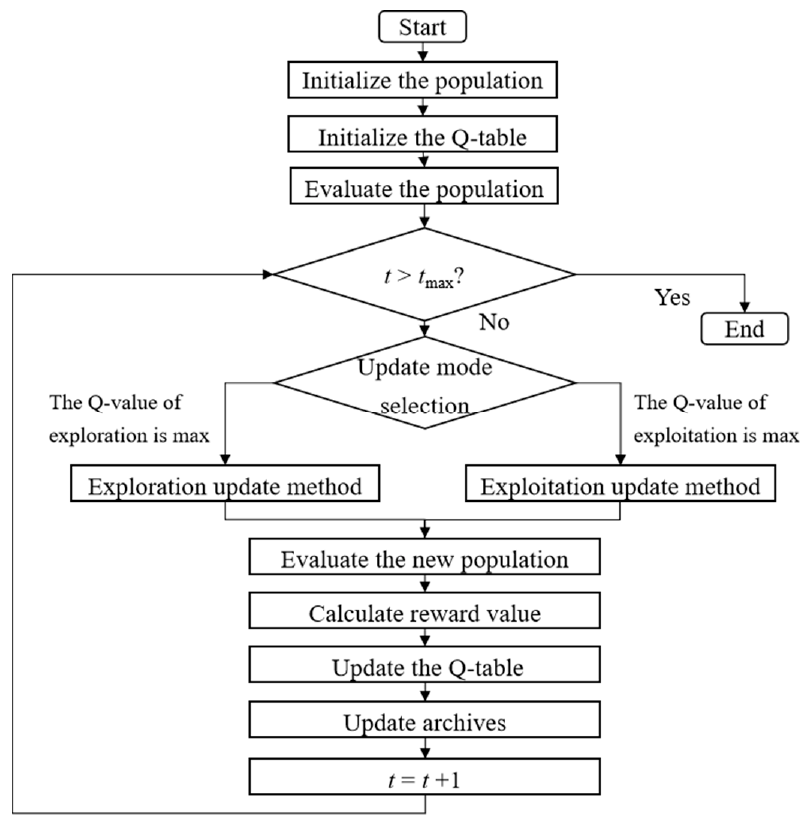
Figure 2. The framework of GMOPSO-QL.